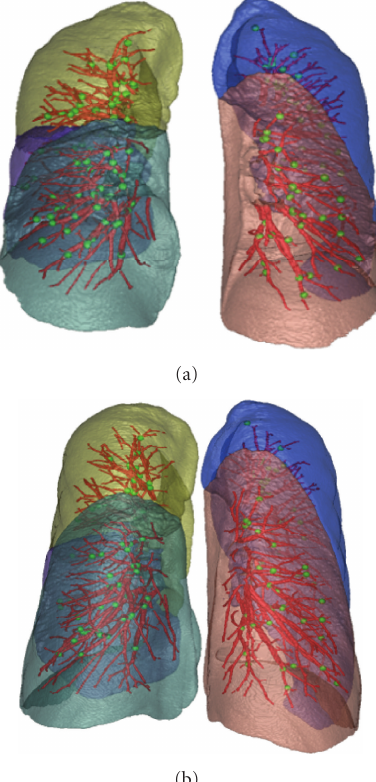
Figure 3: Distribution of landmarks (green points) selected at vessel-tree branch points on (a) FRC and (b) TLC scans of one subject. Vessel trees are marked as red curves. Di ff erent lobes are marked using di ff erent